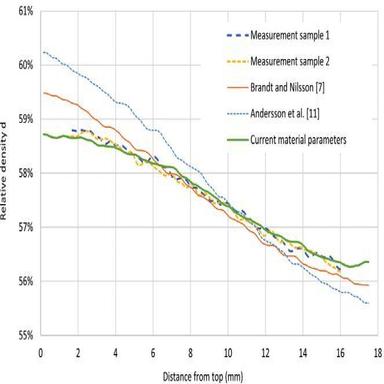
Average relative density as a function of height in the plane shown in Fig. 8. The measurement has a surface artefact in the beginning and at the end, which is removed from the graph.